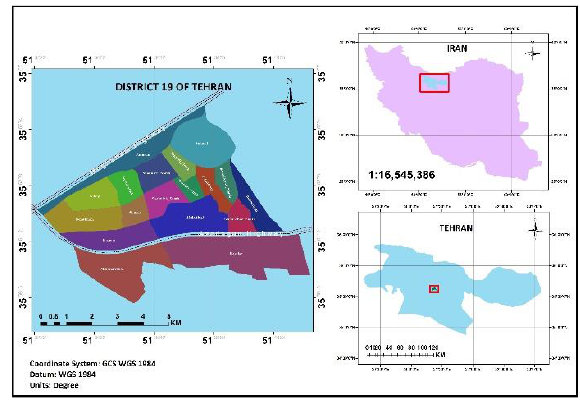
Figure 1 . Map of the study